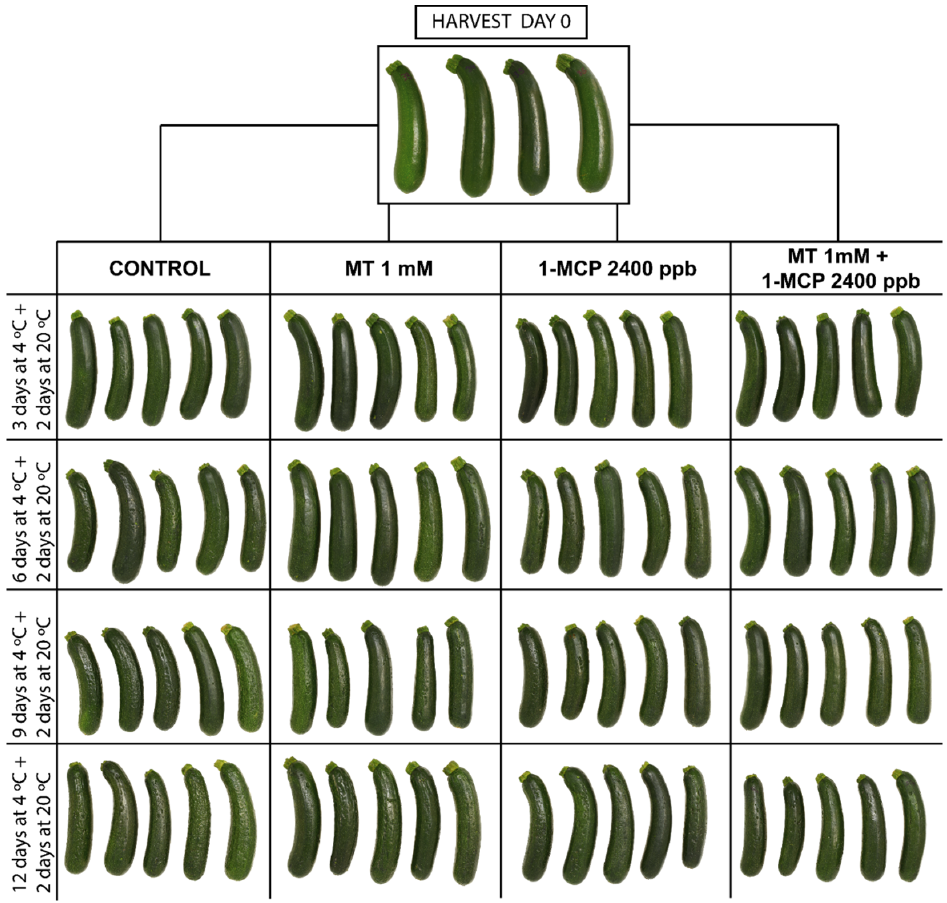
Figure 2. Photography displays the external visual aspect of ‘Cronos’ zucchini fruit treated with melatonin at 1 mM (MT) or distilled water (Control) with or without 1-MCP after 3, 6, 9 and 12 days of cold storage plus 2 days at 20 °C.